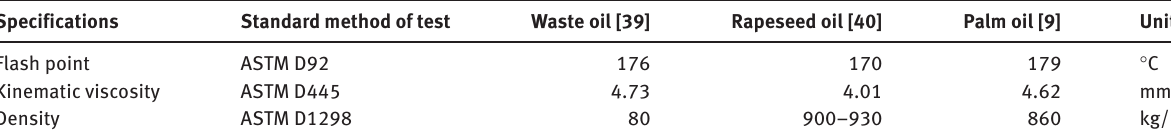
Table 4: Comparison of biodiesel produced from palm oil, rapeseed oil, and waste oil.